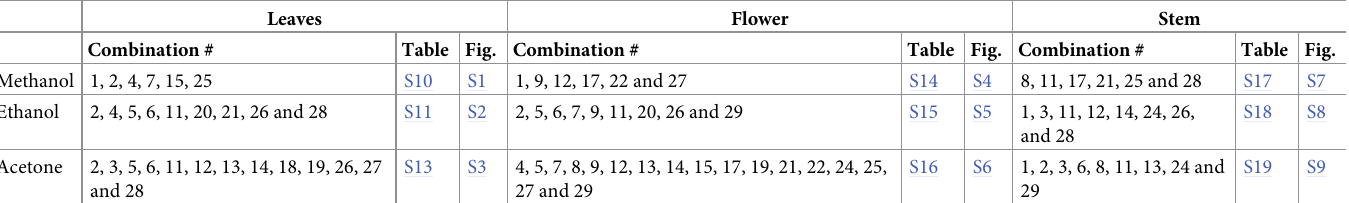
Table 2. Comparative summary of antimicrobial properties of A . absenthia leaves, flower and stem extracts (methanol, ethanol and acetone) against all microbes under study.